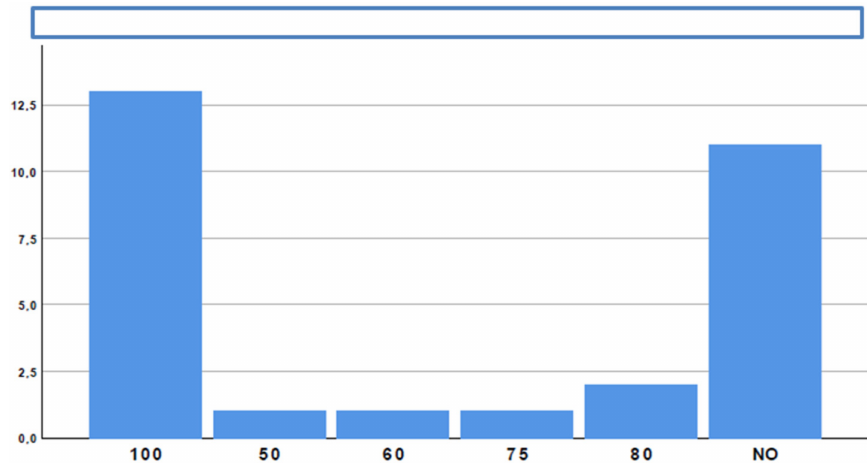
Figure 6. Perceived rate of application of EUS-GEA in the palliative setting.